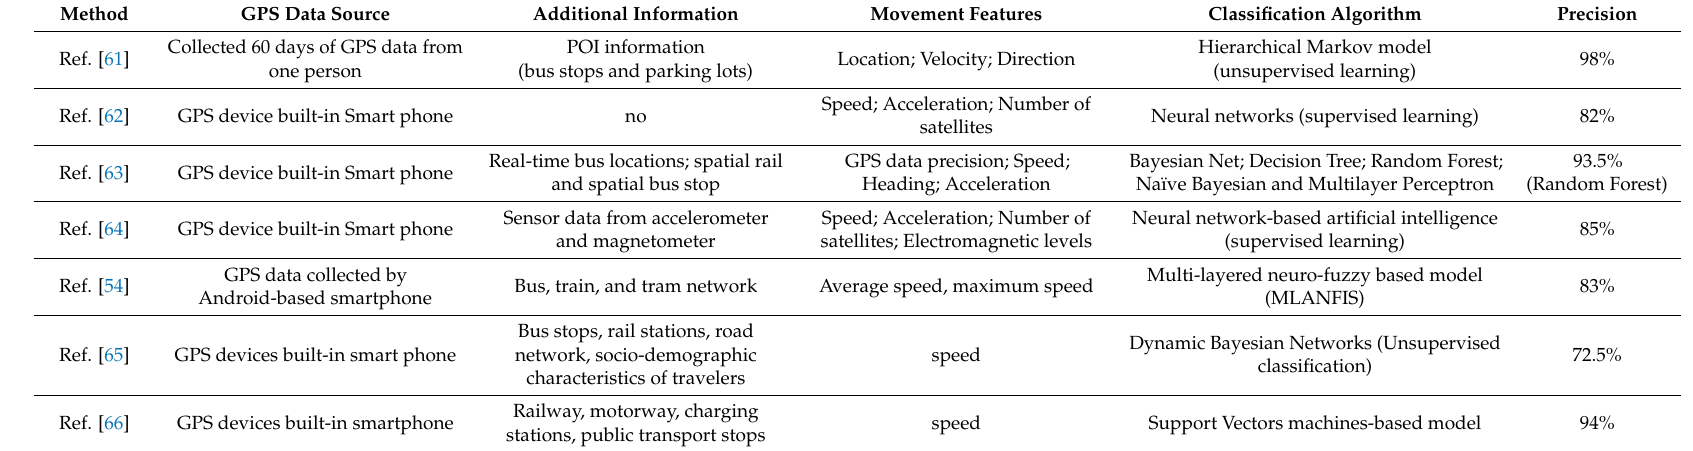
Table A1. MMT classification evaluation based on point-based